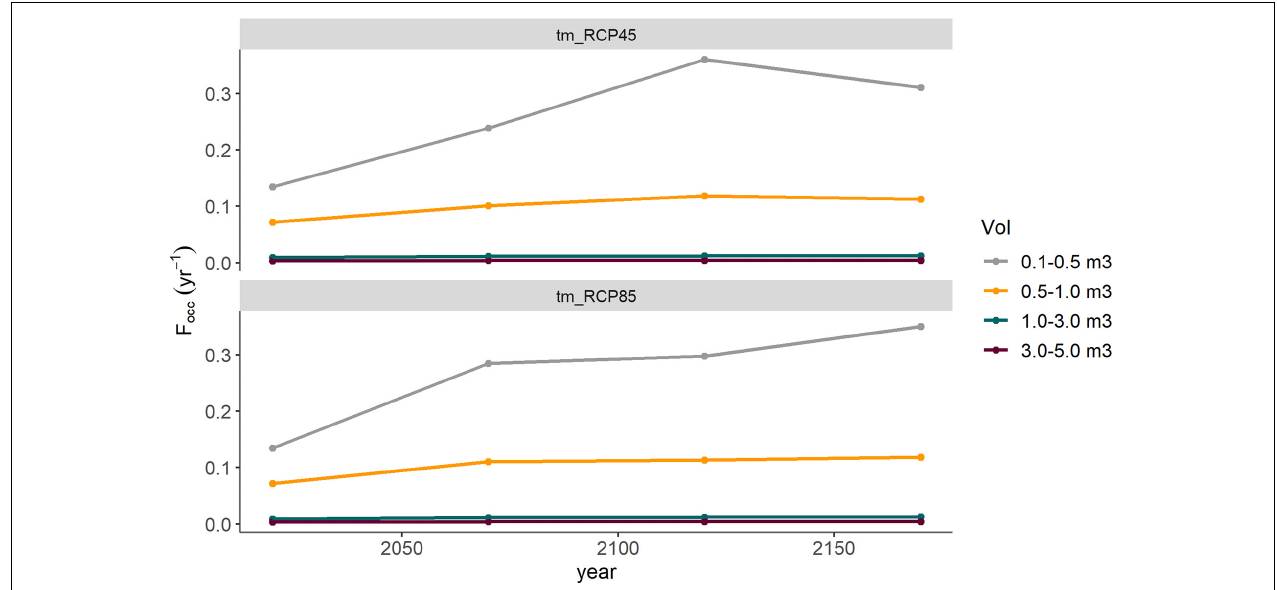
FIGURE 11 | Predicted development of the occurrence frequency of the considered block volume scenarios at the level of the railway until 2200 for the future forest scenarios under climate scenario RCP4.5 ( above ) and RCP8.5 ( below